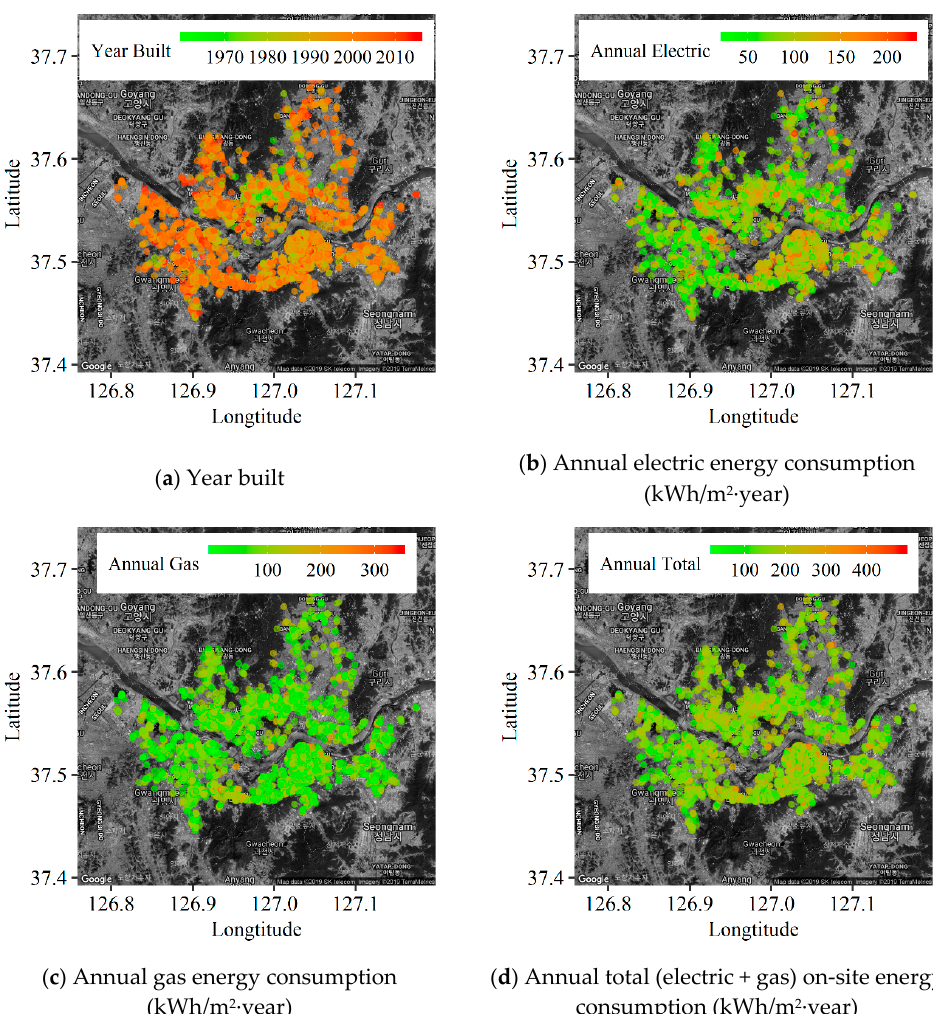
Figure 2. Maps of the ( a ) year built, ( b ) annual electric energy consumption (kWh/m 2 ∙ year), ( c ) annual gas energy consumption (kWh/m 2 ∙ year), and ( d ) annual total (electric + gas) on ‐ site energy consumption (kWh/m 2 ∙ year) of 4625 office buildings in Seoul, Korea, for the year 2015. (The ggmap package on R was used). Table 1. Descriptive statistics of year built and annual energy consumption of 4625 office buildings in the 25 districts of Seoul, Korea, in 2015.